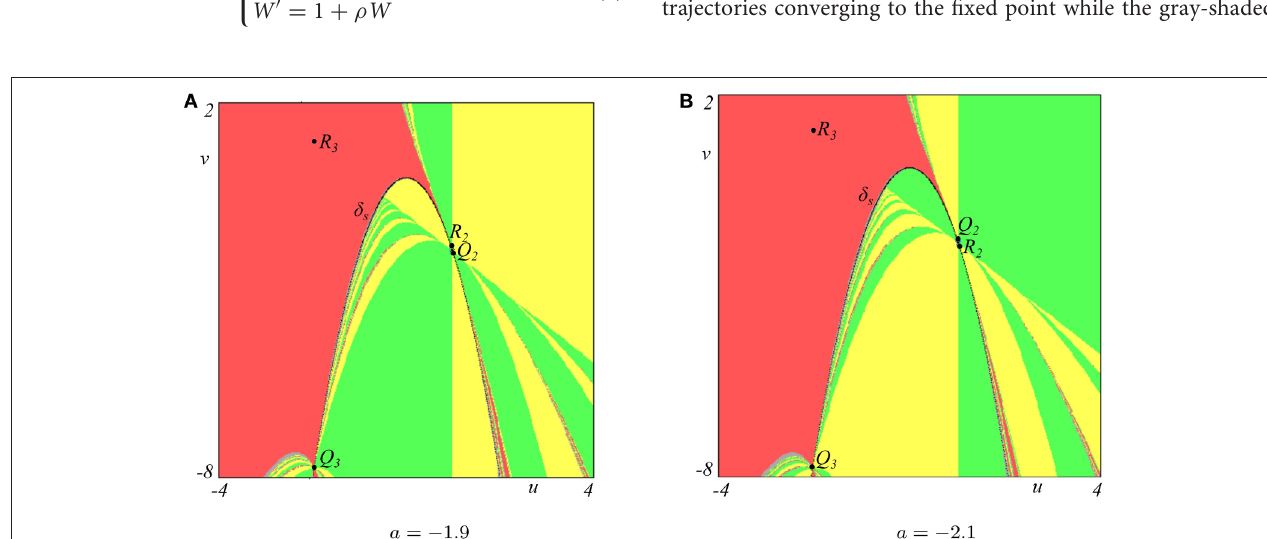
2. (B) a 2.1, just after the bifurcation occurring = − = −